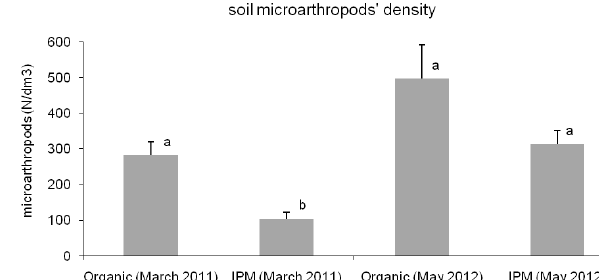
Figure 2. Density of soil microarthropods measured as means ( ± SE) of individuals, ( N ) / 1 d m 3 soil volume, determined for man- agement and data sampling. Within the year, different letters indi- cate significance in the values’ comparison ( t test, P < 0.05).